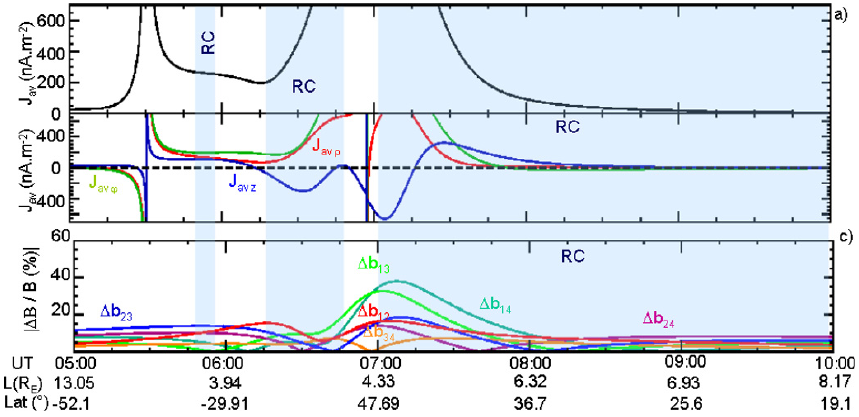
Fig. 8. Estimation of the current density and 1b ij along the Cluster orbit on 15 May 2009 ring current region crossing for a dipolar model. In each frame, the blue shaded areas indicate the time intervals when the ring current is observed on C1